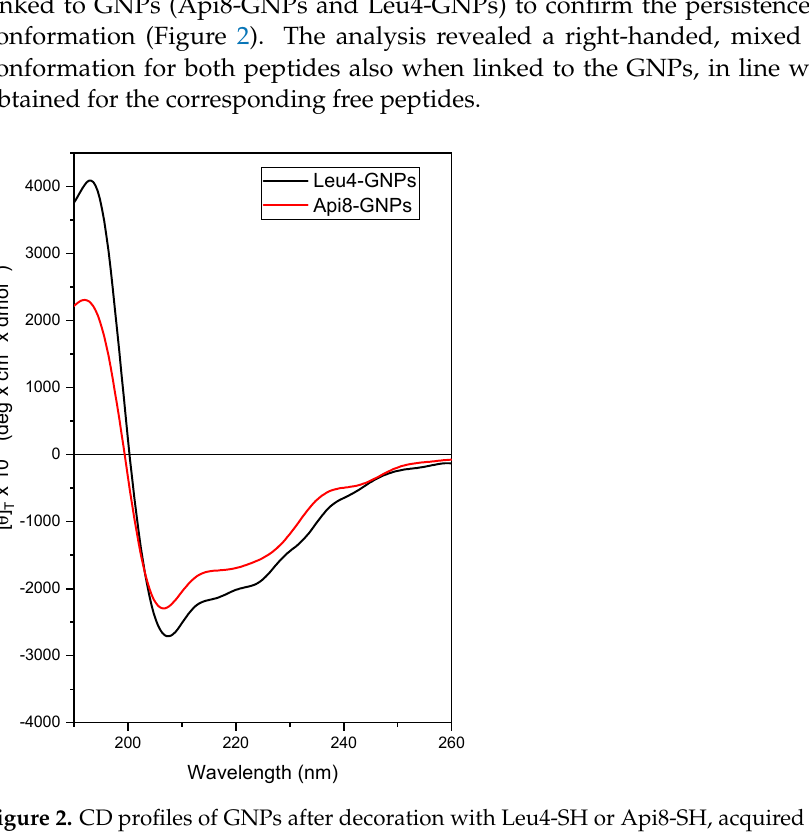
Figure 2. CD profiles of GNPs after decoration with Leu4-SH or Api8-SH, acquired at 25 °C in H 2 O (peptide-GNP concentration: 10 − 6 M).